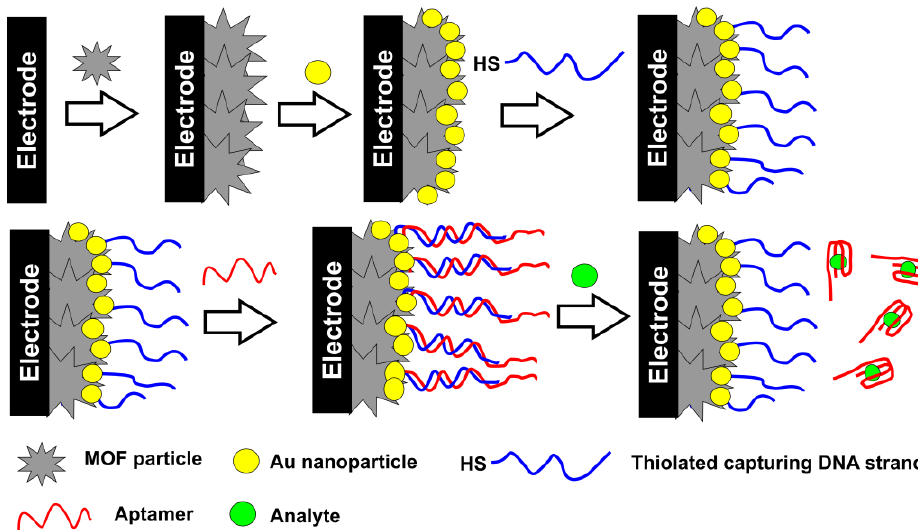
Figure 7. Immobilization of aptamer molecules via hybridization with auxiliary DNA strand and the following interaction with an analyte releasing the aptamer from the surface layer.